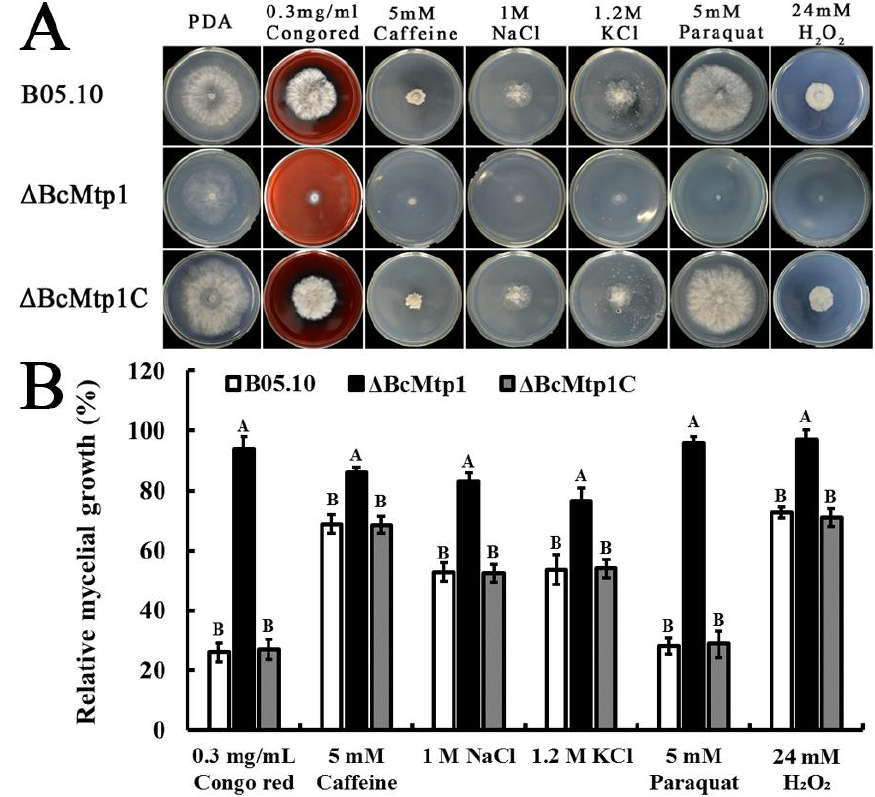
Figure 3. Sensitivity of B05.10, ∆ BcMtp1 and ∆ BcMtp1C to various stresses. ( A ) Comparisons were performed on PDA medium supplemented with Congo red, caffeine, NaCl, KCl, paraquat, and H 2 O 2 , indicated in the figure. ( B ) Inhibition of mycelial growth was analyzed after each strain was incubated for 3 d on PDA supplemented with different compound, as described in the figure. Bars denote standard deviation from three experiments. Values on the bars followed by the same letter are not significantly different at p = 0.05.